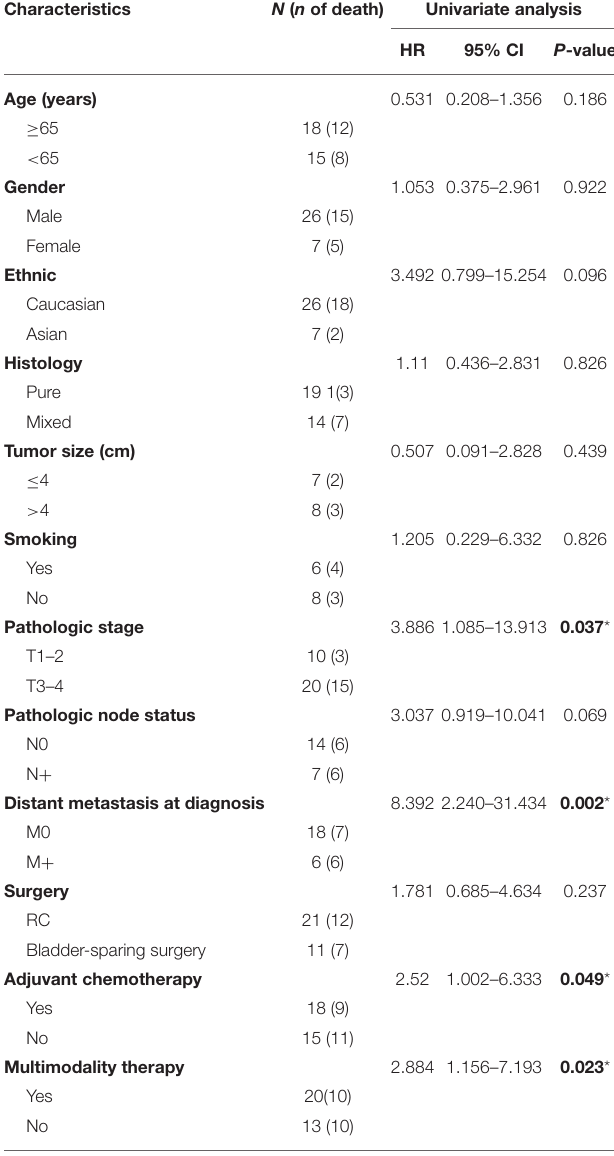
TABLE 2 | Univariate analysis of prognostic factors for OS of the patients.